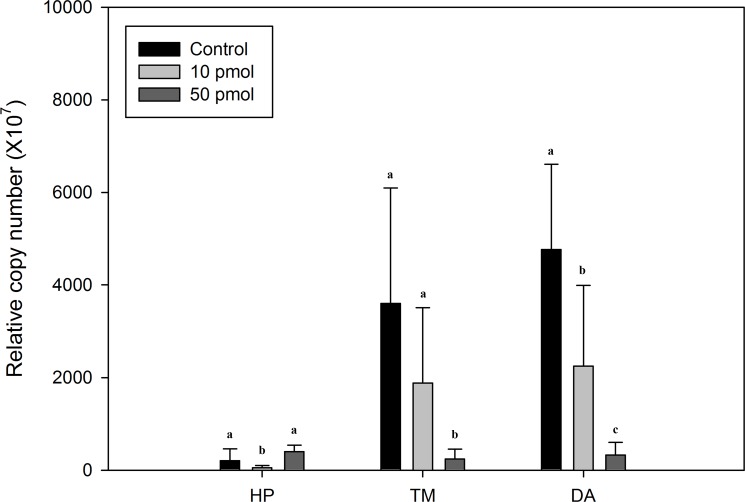
Comparison of Liv-AdipoR transcripts before and after its long dsRNA injection.Transcription level was measured in three tissues including hepatopancreas (HP), thoracic muscle (TM) and deep abdominal muscle (DA) 3 days after dsRNA injections at deep abdominal muscle with three different concentrations (1× PBS, 10 pmol, 50 pmol). Copy numbers were normalized by the number of 18S rRNA. Statistical difference (P < 0.05) are shown in different letters.